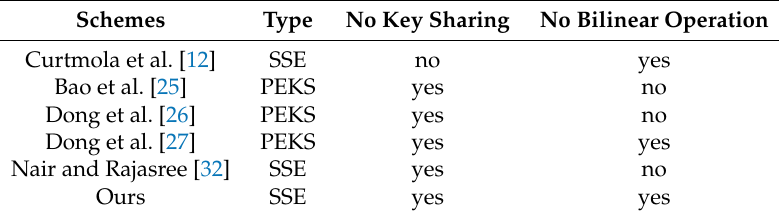
Table 2. Feature comparison of multi-user searchable encryption